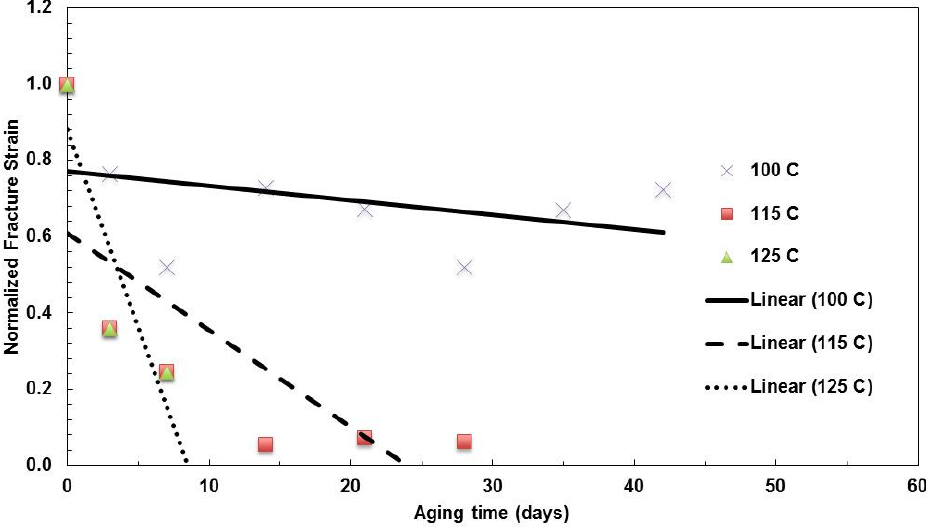
Figure 10. Summary of the change in fracture strain with aging time for films with a 31-nm layer thickness aged at various